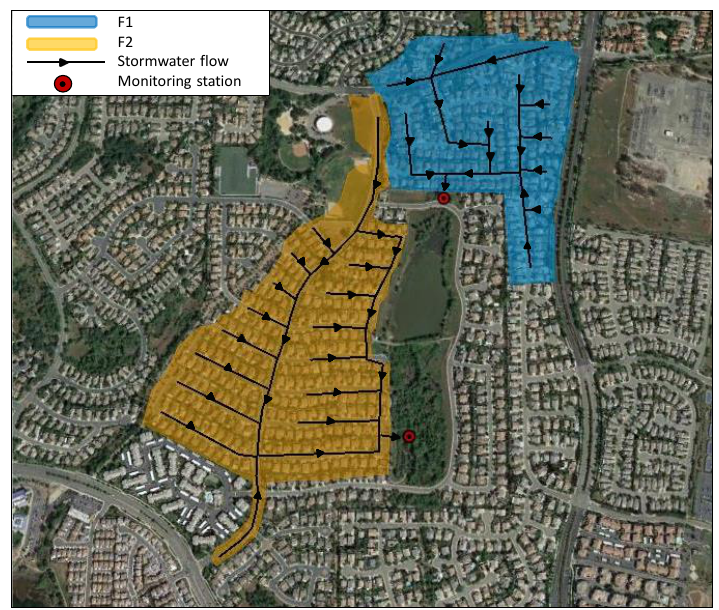
Figure 1. Study watersheds with the location of their monitoring stations and stormwater flow directions. (Adapted from Google Earth https://earth.google.com/web/).